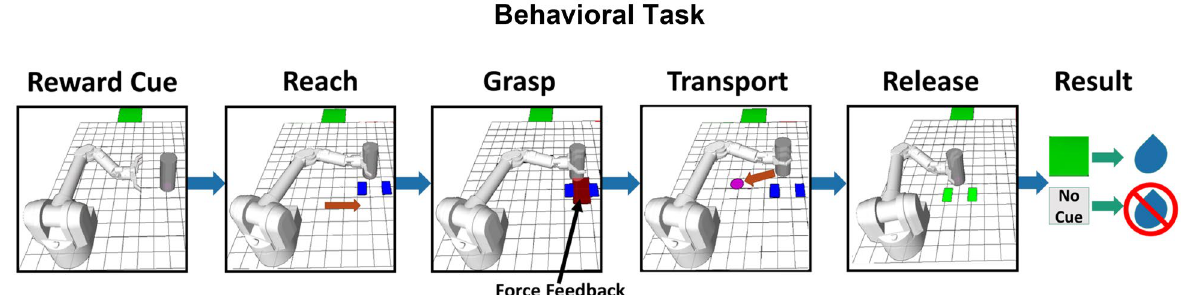
Figure 1. Flow diagram illustrating a single trial. The task is visually identical for both the manual and observational versions. The reward cue (green square, R1) was shown for R1 trials in cued blocks only. The absence of the green square indicated a non-rewarding (R0) trial during cued blocks of the task. The robotic arm started in a resting position for all trials (left-most image). There was no cue provided during the “Reward cue” period for any trials during uncued blocks. Please note, under experimental conditions with NHPs, the background of the grid and free space around the robotic arm and object were black. For the reader’s benefit and visual clarity, both areas have been changed to white here. Blue rectangles are grip-force targets and were seen for the duration of a trial. The red rectangle shows visual force feedback of the NHPs grip-force output initially but is no longer shown once the NHP has reached the acceptable force range (blue